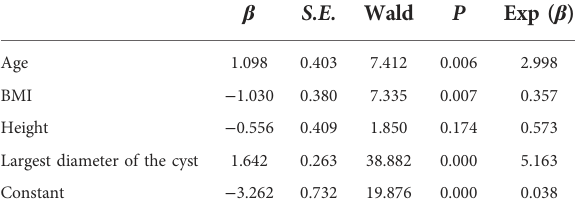
TABLE 3 Predictive factors of the LESS-E approach in multivariate